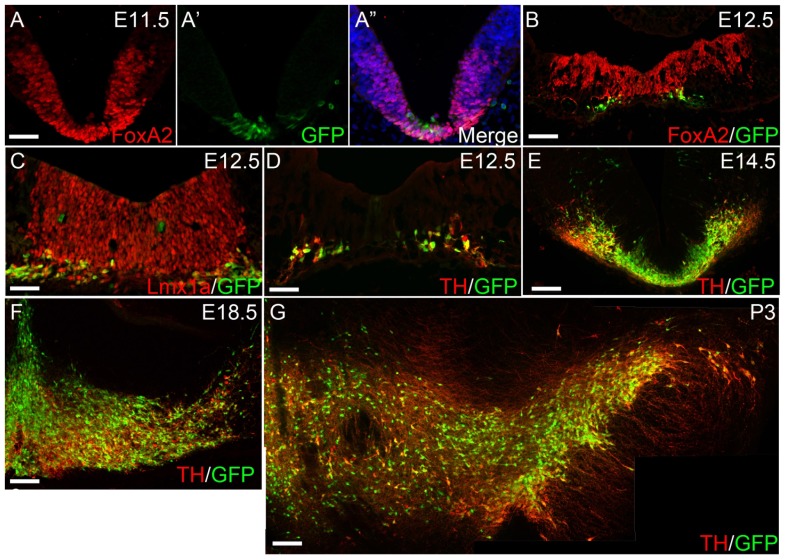
Expression of mDA neuronal markers in hTH-GFP rats at various developmental stages.The mDA progenitor marker Foxa2 (A) is widely distributed along the floor plate of the midbrain at E11.5 while GFP (A′) is detected in only a few midline cells in this region. By E12.5, Foxa2 (B), Lmx1a (C) and TH (D) are all expressed in the central portion of the ventral midbrain. However, Foxa2 expression extends more laterally than Lmx1a. TH expression co-labels with GFP but double-labeled cells are seen only at the base of the midline zone. At all stages examined: E14.5 (E), E18.5 (F) and P3 (G), GFP expression closely approximates TH expression in the midbrain. Scale bar  = 50 µm in A, C, D. Scale bar  = 100 µm in B, E, F, G.